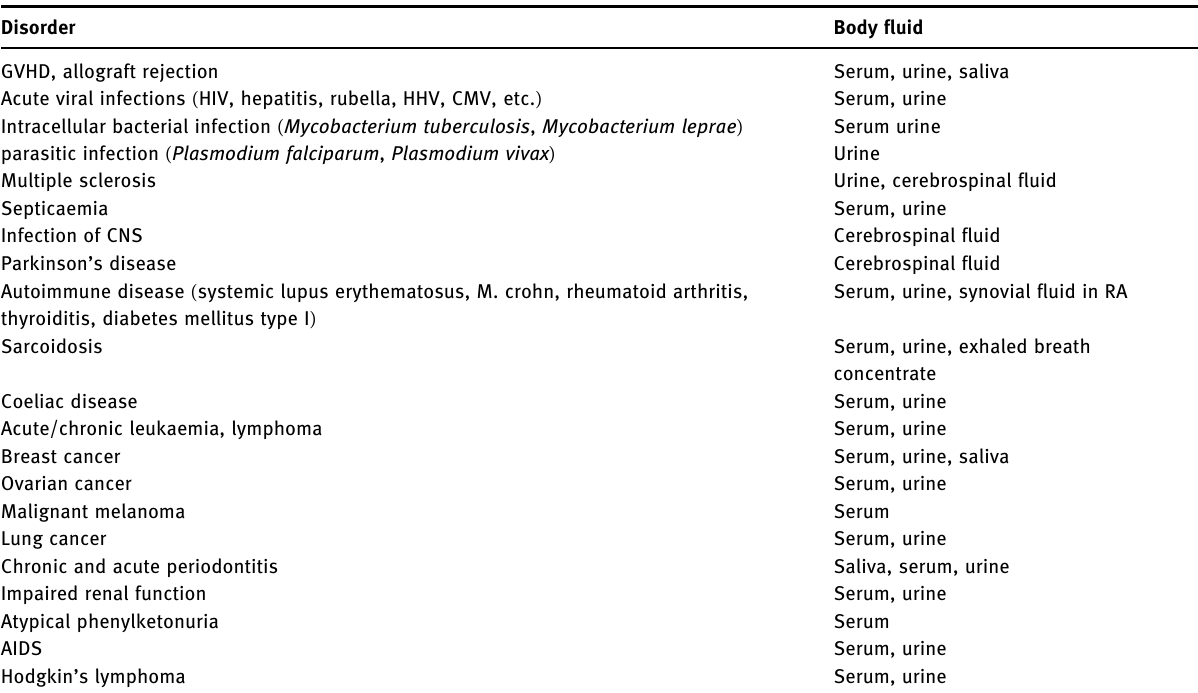
Table 1: Disorders characterized by increased neopterin concentrations in body fl uids Disorder Body fl uid GVHD, allograft rejection Serum, urine,